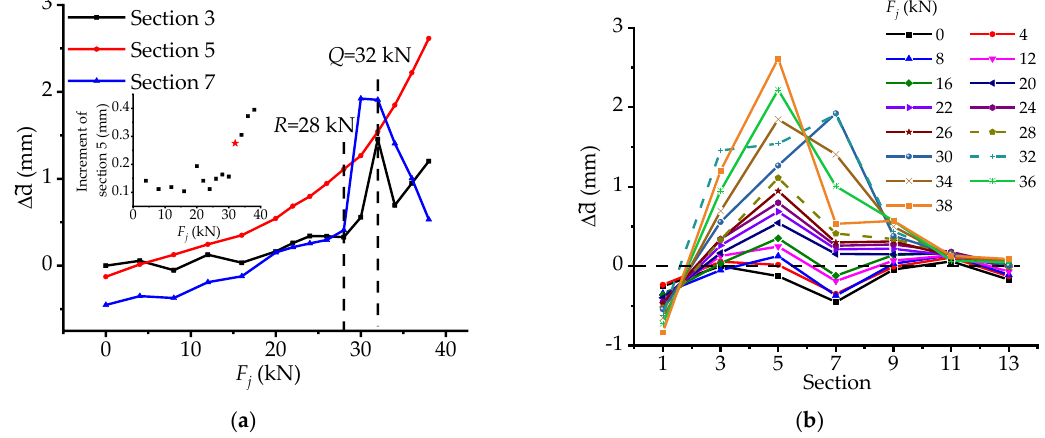
Figure 12. The changing features of generalized torque modes: ( a ) The trend changing features of generalized torque stressing state mode; and ( b ) The distribution pattern changing features of generalized torque stressing state mode.